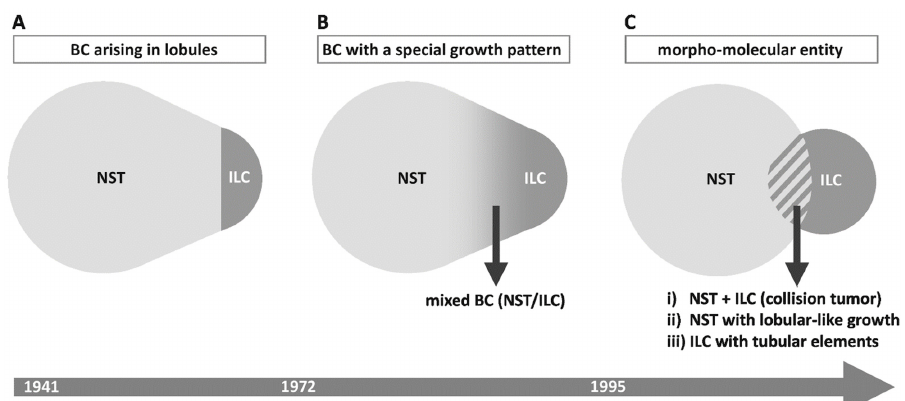
Figure 1. Different concepts of ILC as a special tumor entity and their implications. This is a Venn diagram-like schematic presentation of the relation between BC of NST and ILC, according to different concepts. ( A ) ILC as BC arising in lobules and terminal ducts (Foote and Stewart in 1941) [7]. BC of NST and ILC are clearly separated (based on the presence or absence of LCIS). For details, see text Section 2.1. ( B ) ILC as BC with a special growth pattern (1972 until today, consistent with the 5th edition of the WHO classification of tumors) [19,56]. The boundary between BC of NST and ILC is less clearly defined compared to concept “A”. BCs with indefinite histomorphology may be classified as mixed BC NST/ILC. For further details, please see text Section 2.2 and Appendix A Table A1. ( C ) ILC as a morpho-molecular entity (a concept unofficially prevalent in clinical research since the discovery of CDH1 mutations in 1995) [11]. BC of NST and ILC share a morphologic overlap. Cases in the morphologic overlap may be interpreted as (i) collision tumors, (ii) NST with lobular- like growth pattern but no loss of cell adhesion, and (iii) ILC with tubular elements [58,59]. For details, see text Section 2.3. An approximate time scale showing the origin of these concepts is given at the bottom.